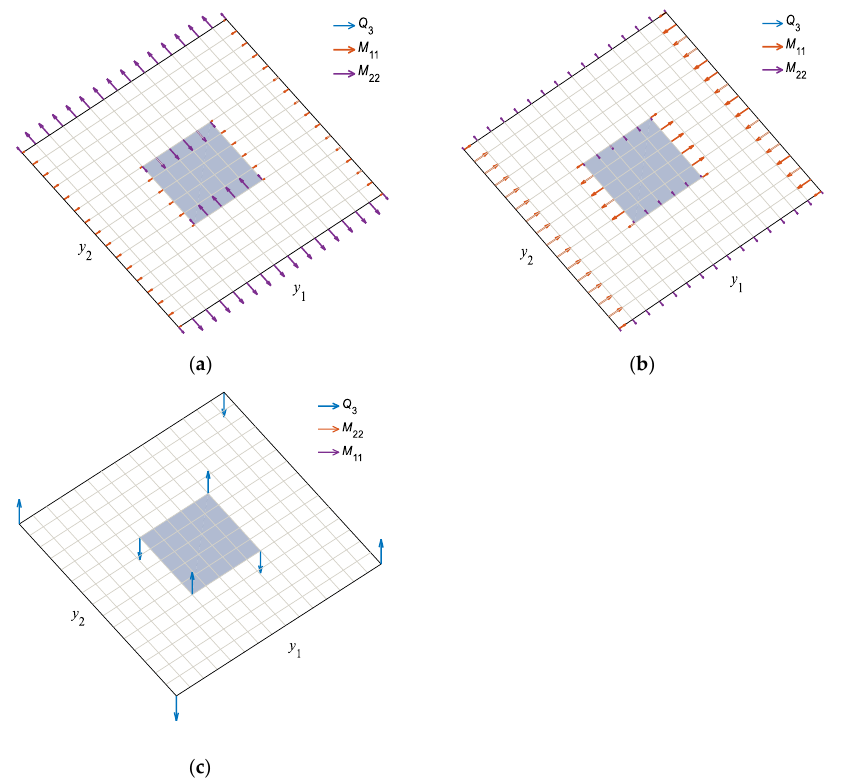
Figure 6. Diagrams of the three columns of 𝑭 2 for the unit cell with single inclusion. ( a ) 𝑚𝑛 = 11 ; ( b ) 𝑚𝑛 = 22 ; ( c ) 𝑚𝑛 = 12.